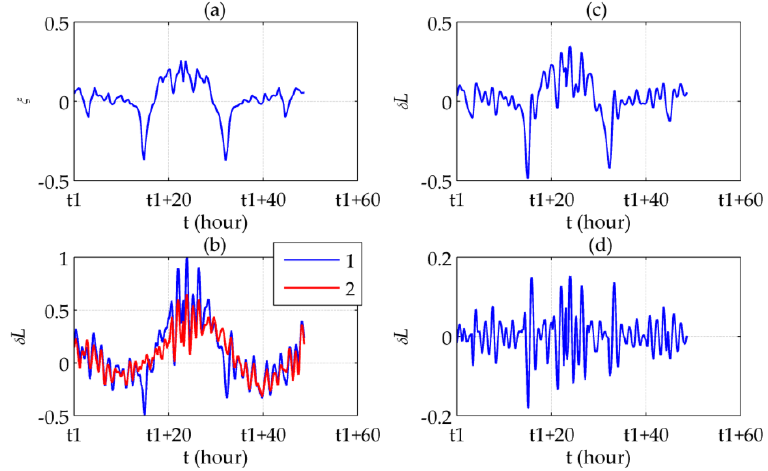
Figure 11. Latitudinal results of the round-trip experiment: ( a ) ξ ; ( b ) Latitude errors before (line 1) and after (line 2) compensation; ( c ) Compensated latitude error; ( d ) Difference between ξ and the compensated latitude error.